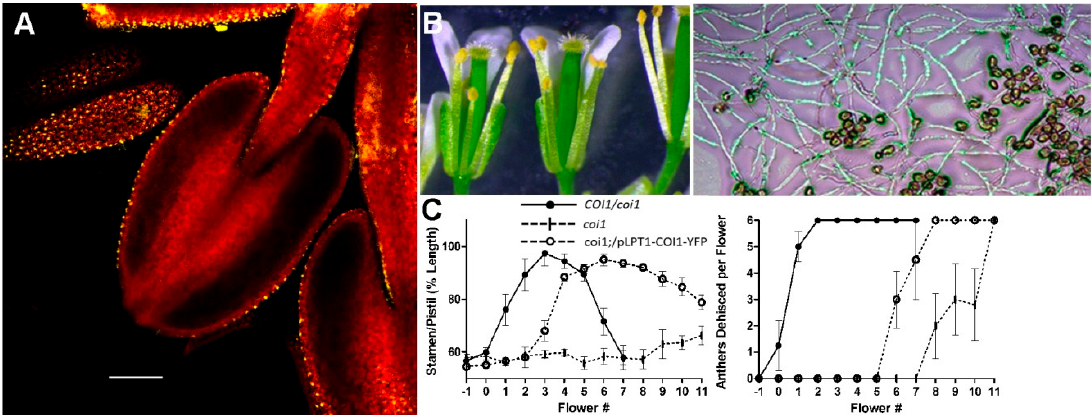
Figure 2. Tissue-specific expression of a COI1-YFP transgene rescues coi1 sterility. ( A ) coi1 plants expressing a LTPpro::COI1-YFP gene show the YFP signal only in epidermal cells of the filament and anther. ( B ) In the transgenic plants, filament elongation, anther dehiscence (left), and pollen-tube germination and growth (right) are all sufficient to restore fertility, although ( C ) filament elongation and anther dehiscence are delayed compared to wild type. (Adapted from Reference [63], with permission.).